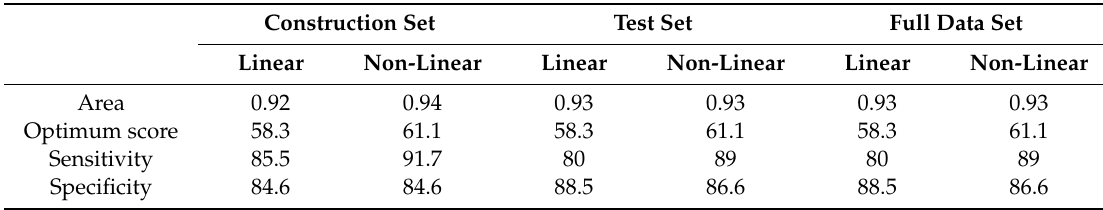
Table 3. The performance of the optimized non-linear classifier in matching the Movement Disorder clinician’s decisions of whether a subject in the construction set met the clinical criteria for DAT (criteria positive (CP)) or did not (criteria negative